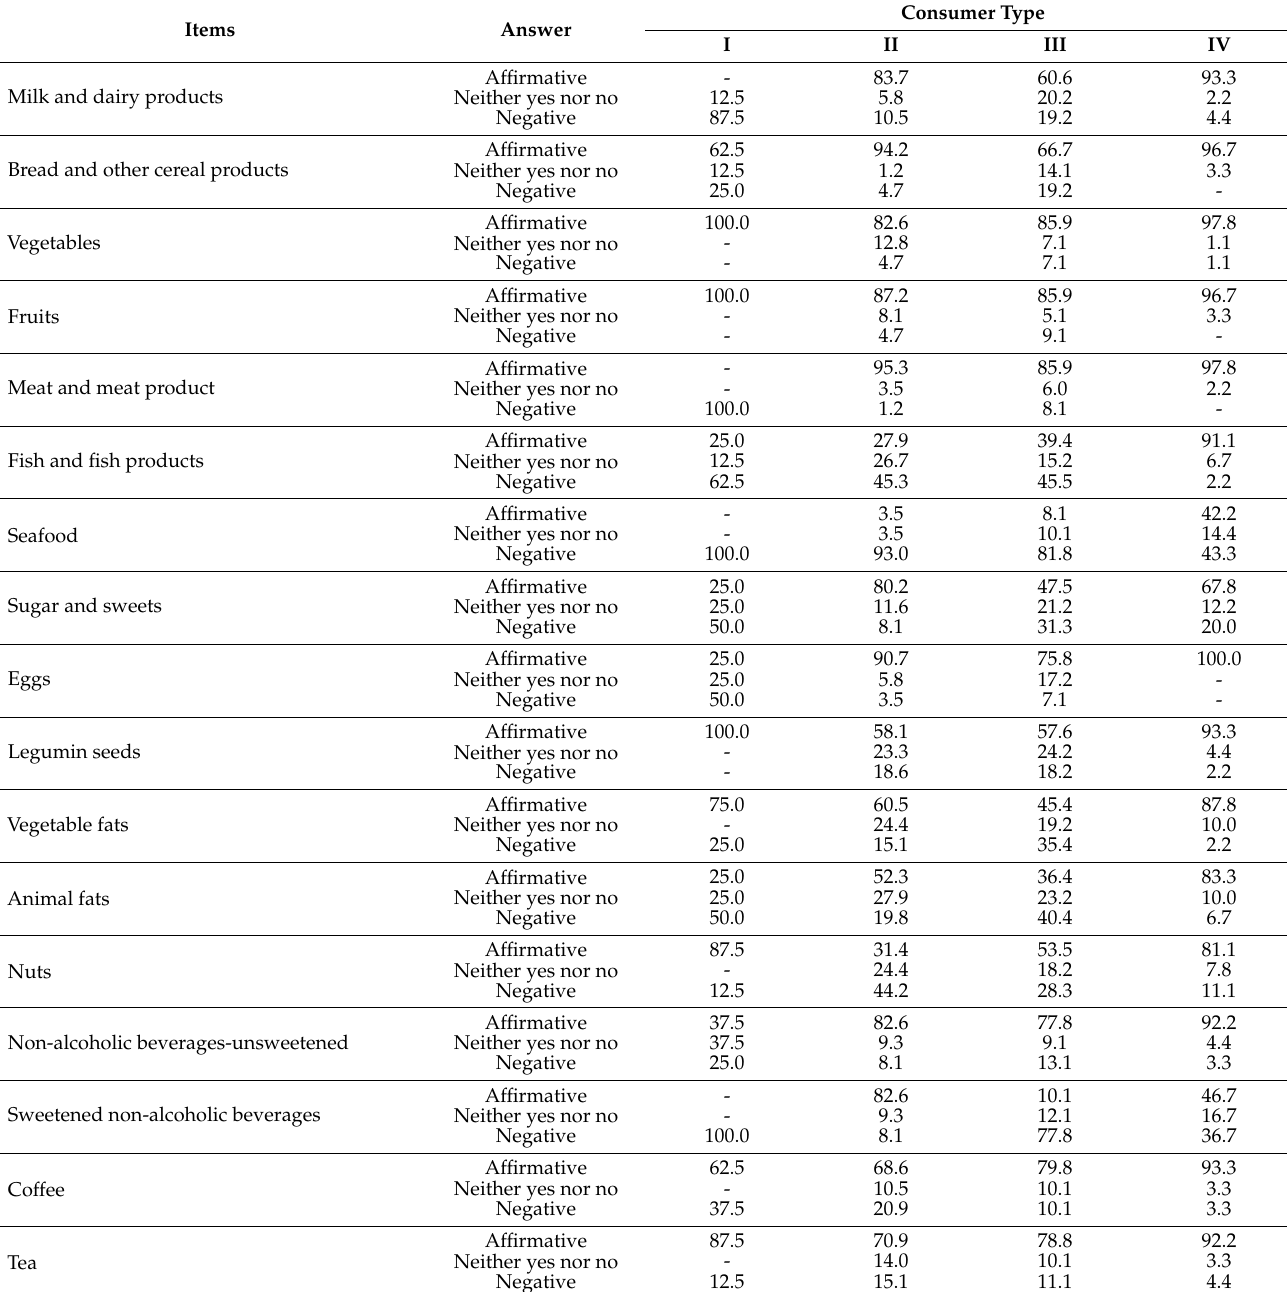
Table 8. Characteristics of the types of Slovak consumers by food and beverages consumed ( n = 300, in